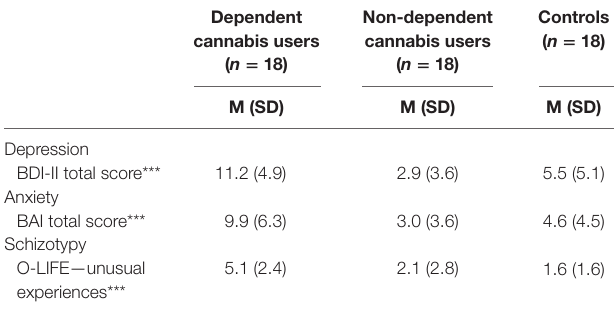
Table 4 | Depression, anxiety, and schizotypy in dependent cannabis, non- dependent cannabis, and control groups